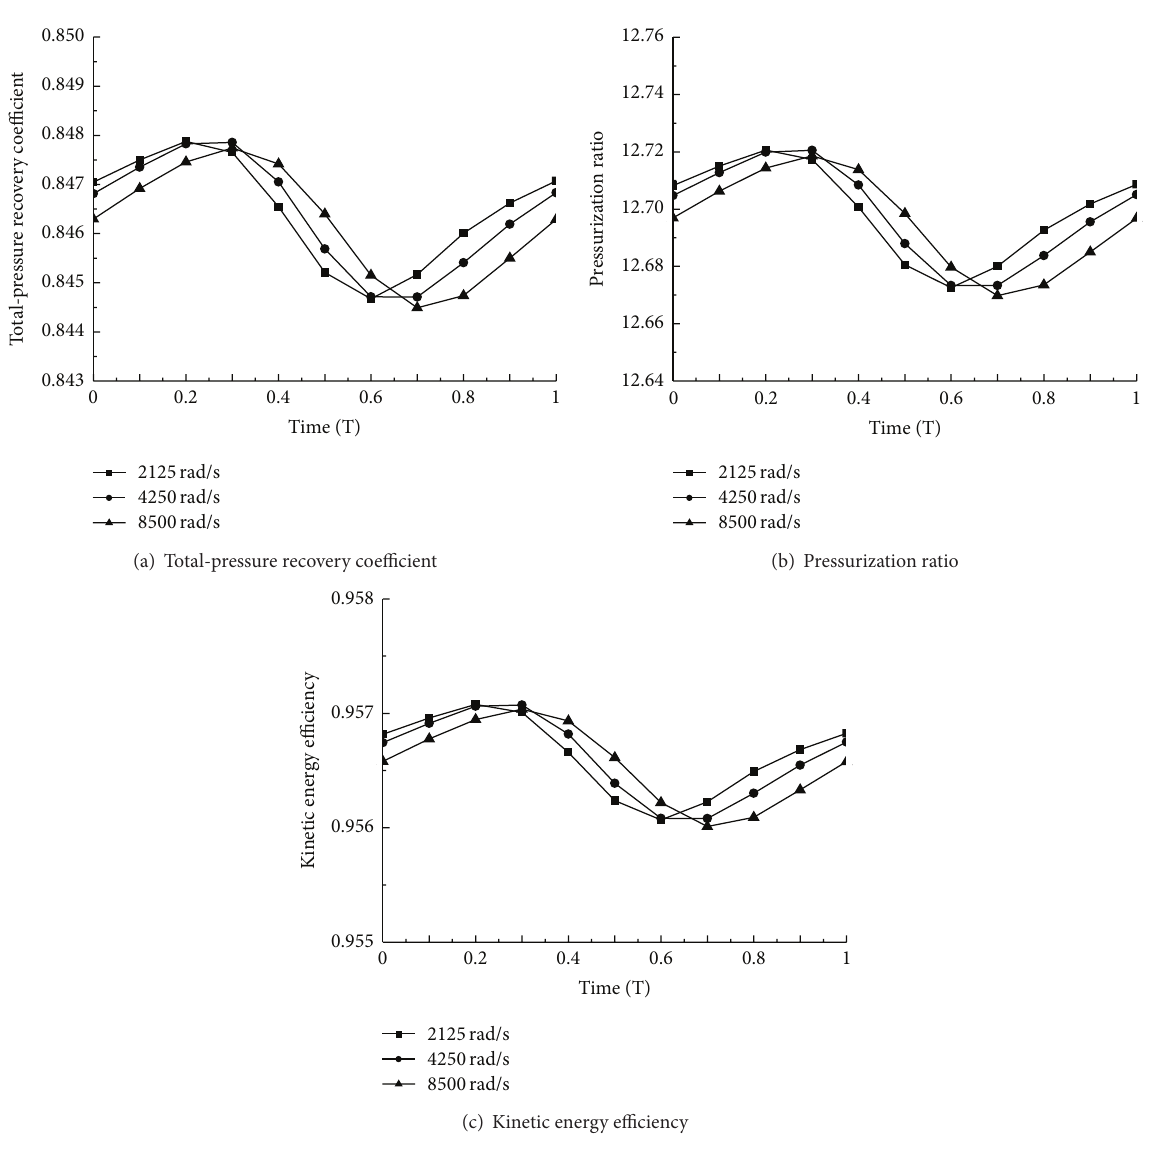
Figure 18: Flow performance in different whirling frequencies during a whirling motion